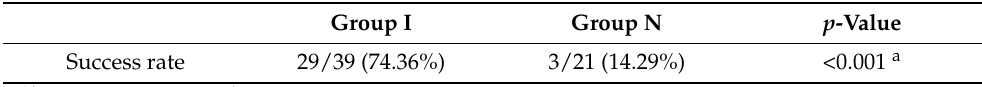
Table 3. Comparison of success rate between Group I and Group N. Group I Group N p -Value Success rate 29/39 (74.36%) 3/21